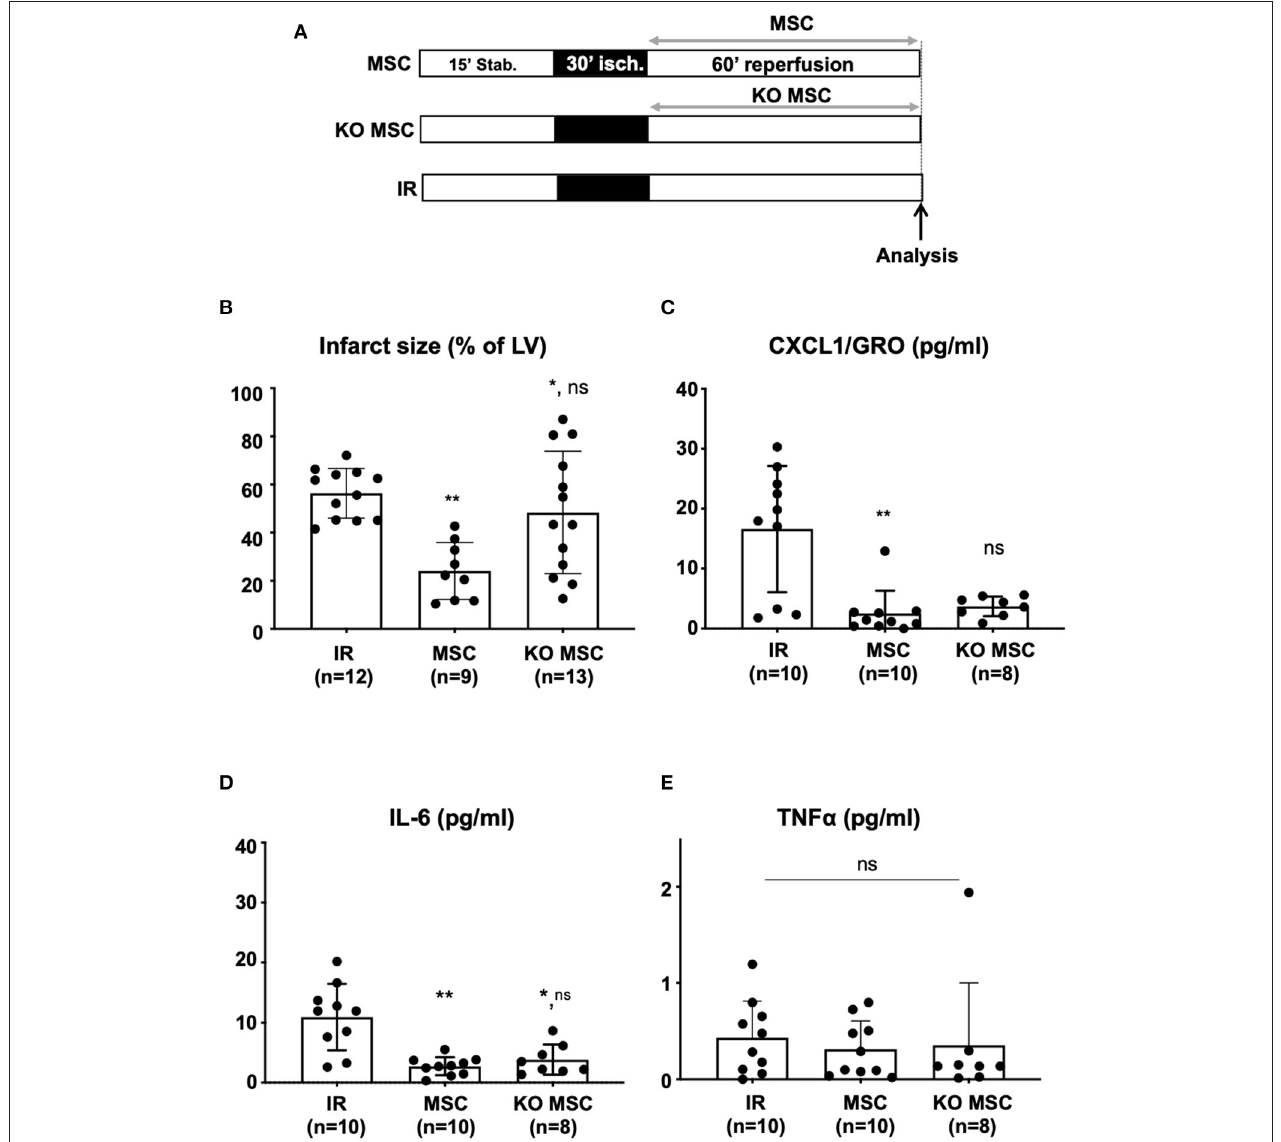
FIGURE 4 | (A) Isolated hearts perfused ex vivo on the Langendorff system were submitted to perfusion protocol similar to that described in Figure 1A . Reperfusion was achieved with a Tyrode solution alone in the IR group or with a Tyrode solution prepared at a concentration of 5,000 cells/ml with MSC (MSC group) and with KO MSC (KO MSC group). At the end of the protocol, infarct size analysis was performed on the isolated heart (B) and cytokine production was analyzed (C–E) using the Meso Scale Discovery (MSD) V-Plex Plus Proinflammatory Panel 1 (mouse) kit. Statistical analysis was performed using the Kruskal-Wallis test with the Dunn’s post test. (B) Scatter plots and bars (mean ± SD) were represented for infarct size (in % of LV) in IR ( n = 12), MSC (5,000 cells/ml, n = 9), and KO MSC (5,000 cells/ml, n = 13). Statistical significance is noted ** for p = 0.001 (MSC vs IR), * for p = 0.029 (KO MSC vs. IR), and ns for p = 0.075 (KO MSC vs. MSC). (C–E) Scatter plots with bars (mean ± SD) are presented for quantification of TNF α , CXCL1, and IL-6 within coronary effluents collected at 60min after the onset of reperfusion from untreated hearts (IR), hearts treated with wild-type MSC (MSC) and MSC deficient for PPAR β / δ (KO MSC) using the Meso Scale Discovery kit. Statistical analysis was performed using the Kruskal-Wallis test. (C) For CXCL1 (pg/ml), ** was noted for p = 0.0017 (MSC vs. IR), ns was noted for p = 0.34 (KO MSC vs. IR) and for p = 0.28 for (KO MSC vs. MSC); (D) For IL-6 (pg/ml), ** was noted for p = 0.0021 (MSC vs. IR), * for p = 0.028 (KO MSC vs. IR), and ns for p > 0.999 (KO MSC vs. MSC); (E) for TNF α (pg/ml), ns was noted for p =